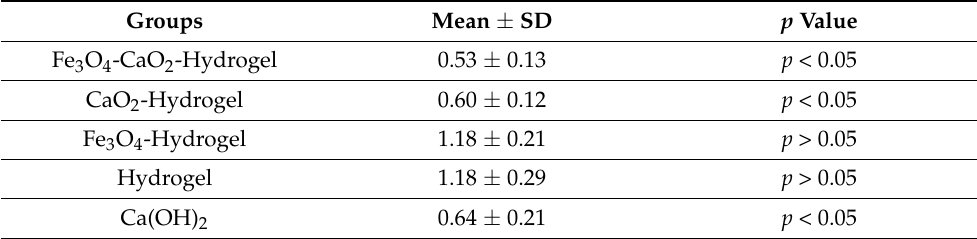
Table 3. Specific data of each group of periapical apical inflammatory infiltration zone. Groups